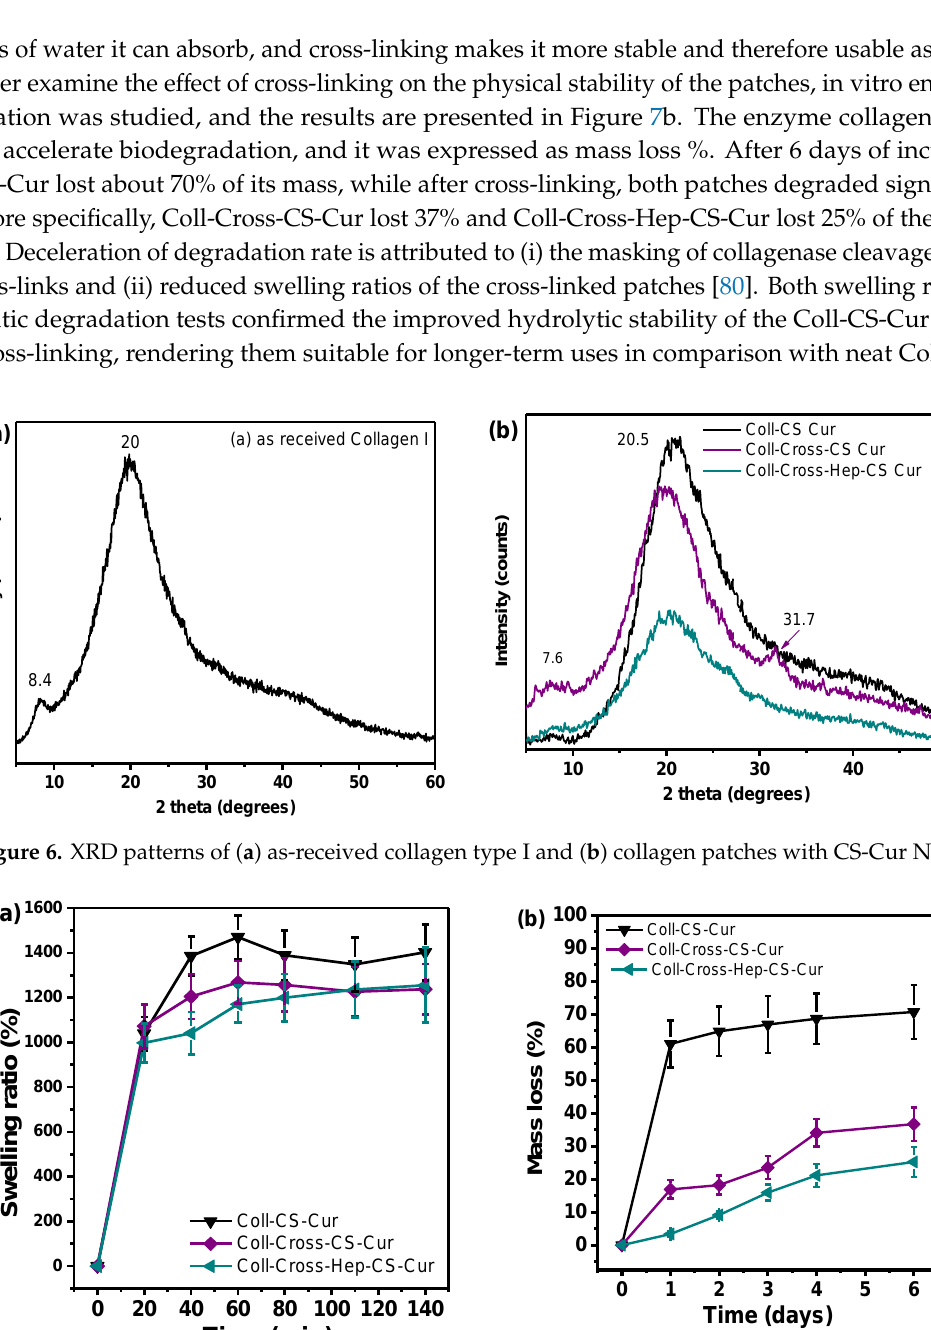
Figure 5. FTIR spectra of collagen patches with CS-NPs.